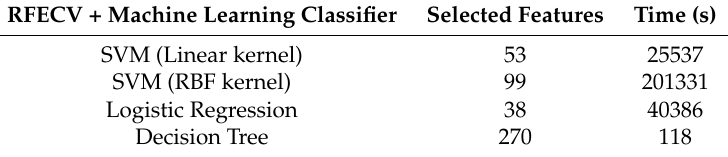
Table 2. Features selected with GridSearch-based Recursive Feature Elimination with Cross-validation feature selection scheme with execution time using various machine learning classifiers for tuning